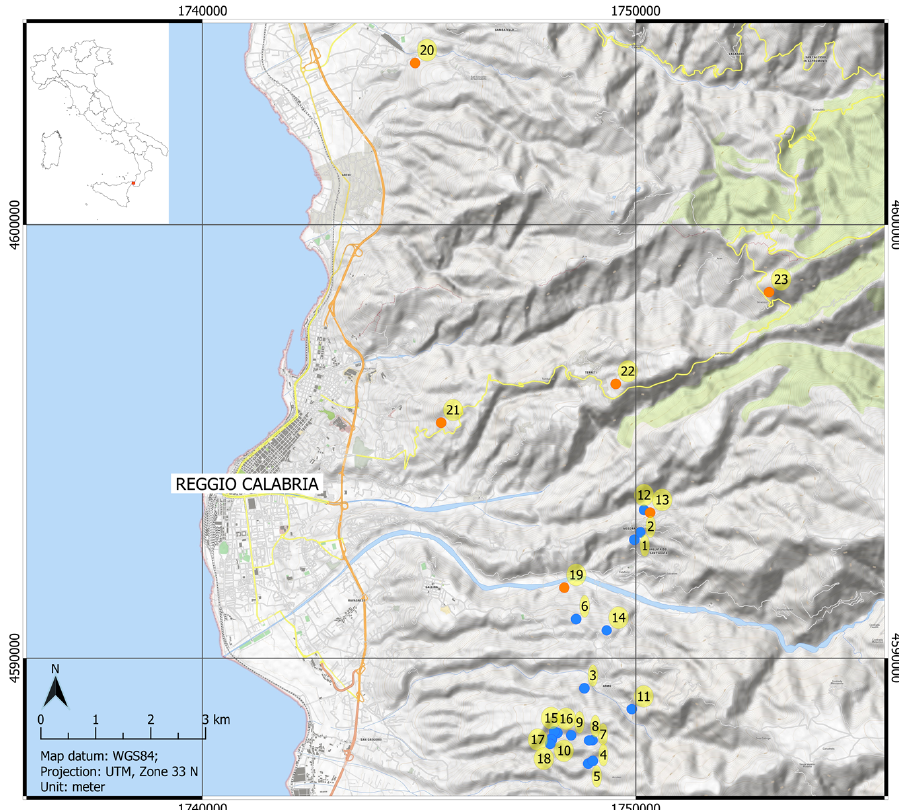
Figure 3. Occurrence points of Salvia ceratophylloides Ard. In blue are the micro-populations currently occurring, in orange the extinct ones. 1—Serro Ciugna, Mosorrofa; 2—Serro Ciugna, Mosorrofa;